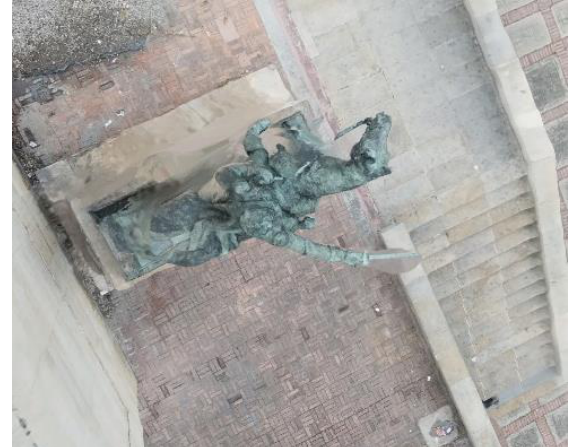
Figure 19: Result of the 3D reconstruction of the sculpture of Equestrian Bolivar.